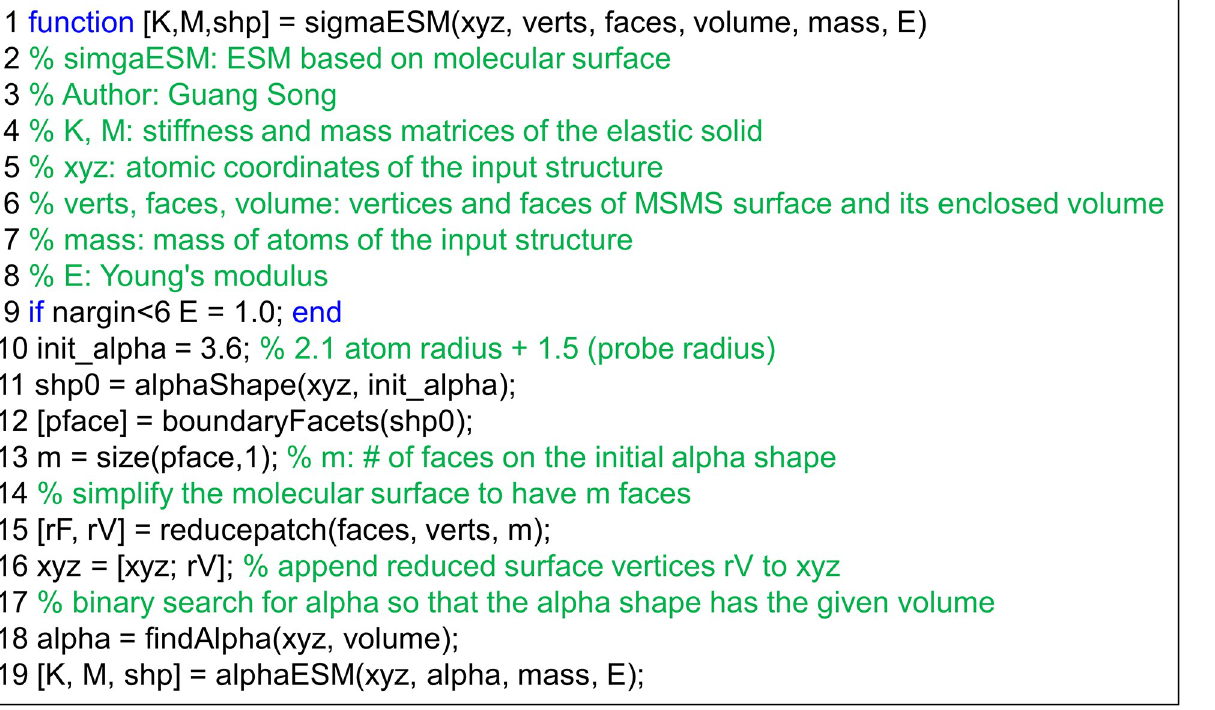
Fig 1. The algorithmic flow of σESM as expressed in a MATLAB script. A complete copy of the above MATLAB script is available at https://github. com/gsongISU/sigmaESMrelease. The scripts for computing stiffness matrix and mass matrix used in alphaESM are available at MATLAB file exchange (https://www.mathworks.com/matlabcentral/fileexchange/27826-fast-fem-assembly-nodal-elements), kindly contributed by Anjam and Valdman [30].